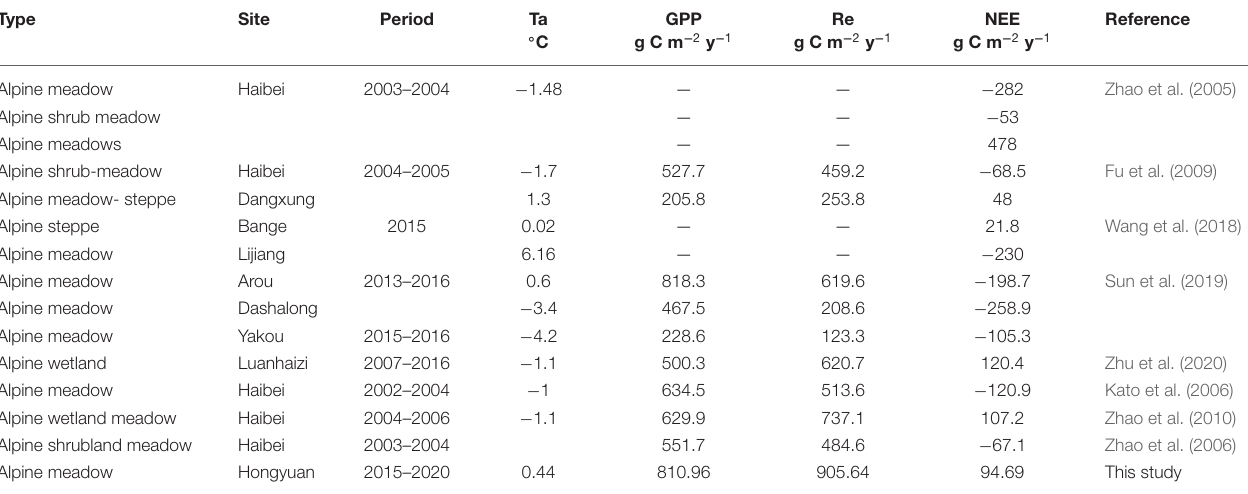
TABLE 2 | Ecosystem carbon fluxes in other alpine meadows published in previous studies.